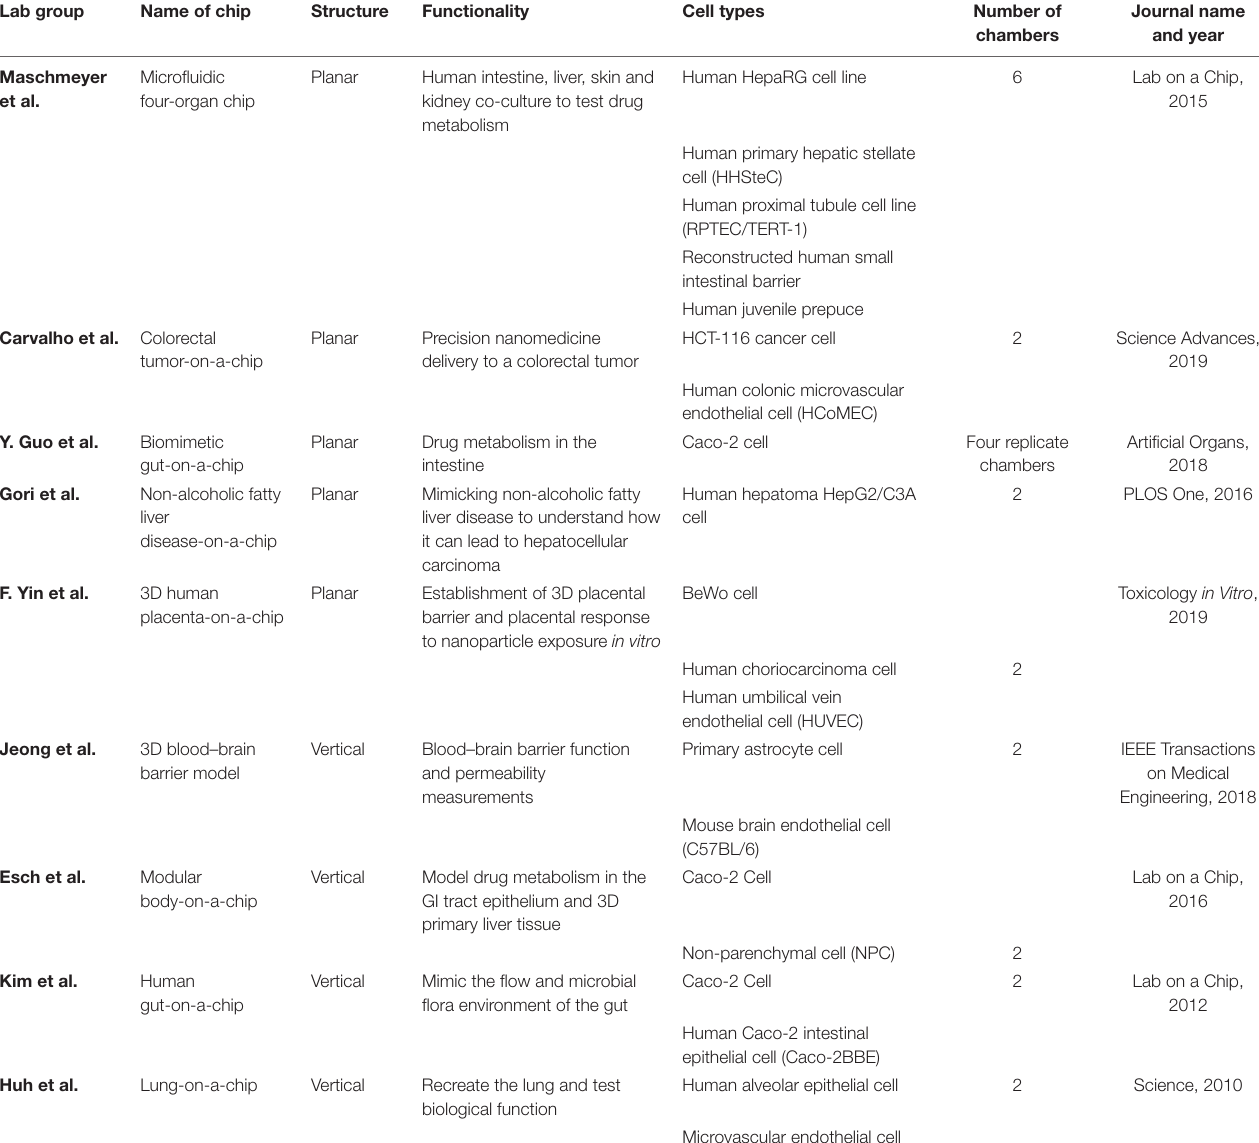
TABLE 2 | Examples of current co-culture OOC models that utilize vertical or planar co-culture designs. Lab